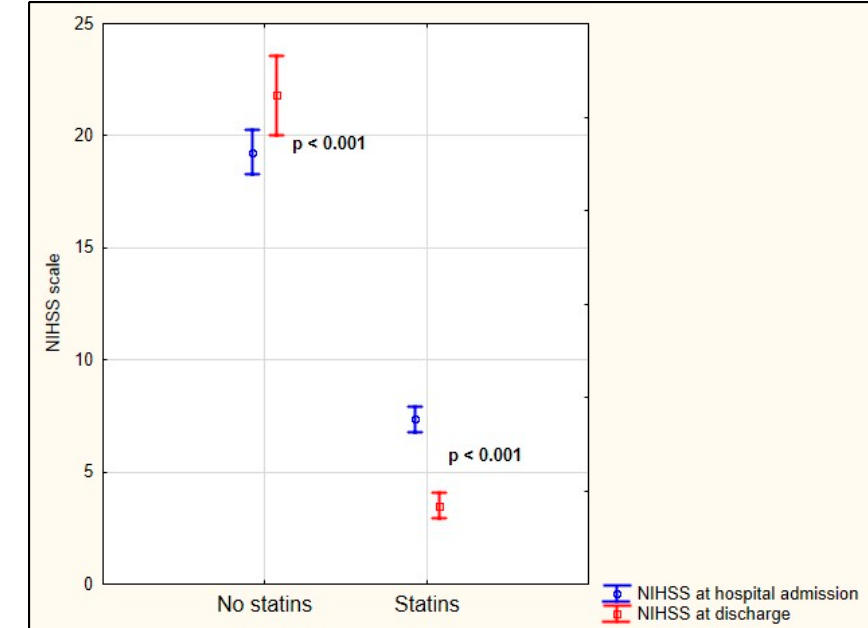
Figure 2. Change in NIHSS scores before hospital admission and at hospital discharge.